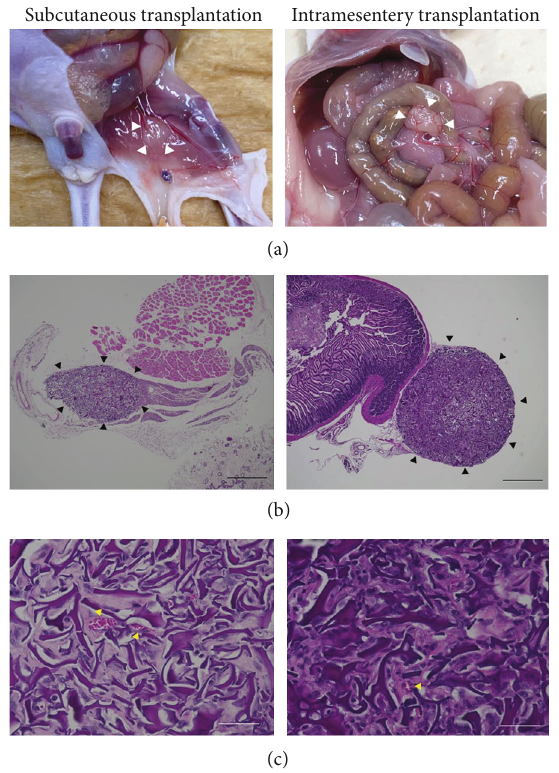
Figure 7: Transplanted small clusters of IPCs at subcutaneous and intramesentery sites. (a) Images at autopsy. The microvessels ran through the surface of both subcutaneous and intramesentery transplanted small clusters of IPCs (white arrowheads). IPCs engrafted in the transplanted sites in the mice. (b) Hematoxylin- eosin (HE) staining in the transplanted small clusters of IPCs (black arrowheads). Bar = 500 μ m . (c) Necrosis in the central location of small clusters of IPCs was not observed, but angiogenesis (yellow arrowheads) was con fi rmed in HE staining. Bar = 50 μ m .